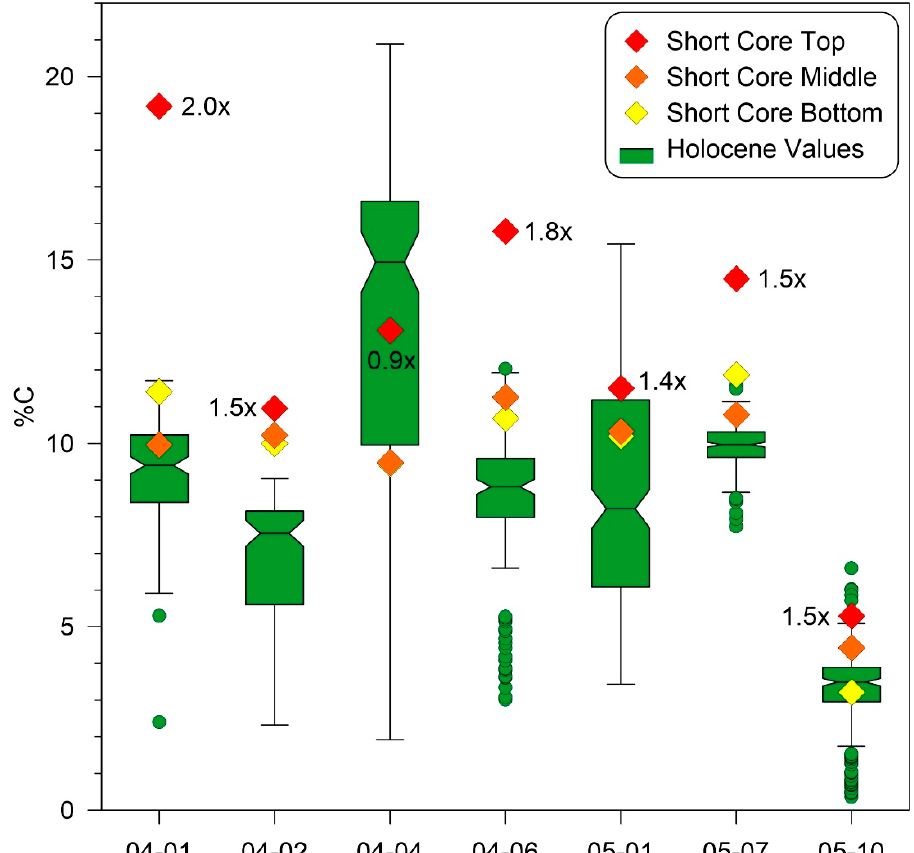
Figure 11. Boxplot of carbon contents measured in Uinta lakes from Holocene-length long cores, and surface sediments collected with a gravity corer. Numbers indicate the enhancement of the modern value (red diamond) over the Holocene median.